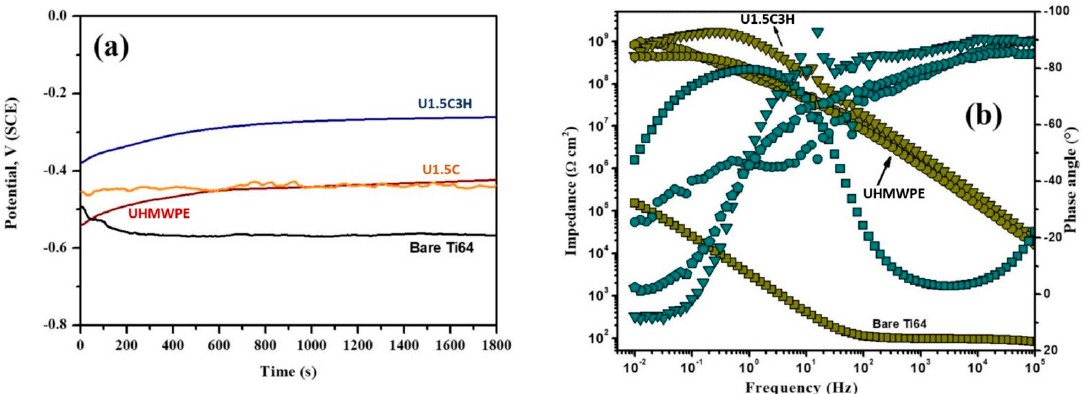
Figure 16. ( a ) Monitoring of open circuit potential values. ( b ) Electrochemical impedance spectroscopy.